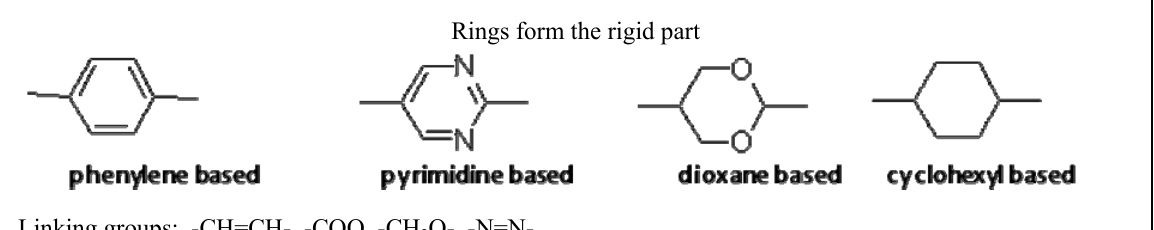
Figure 3. Examples of typical groups which represent the main constituents of calamitic liquid crystalline